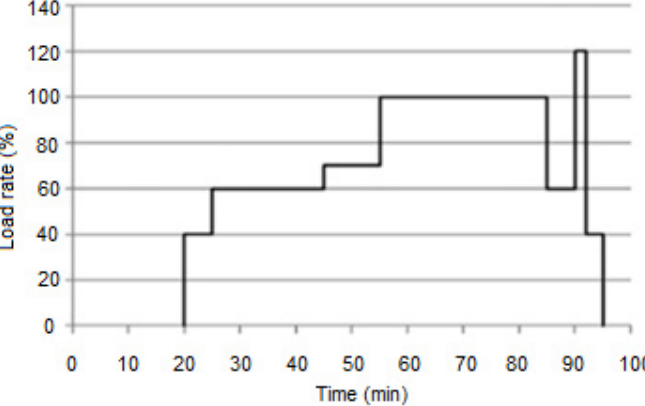
Figure 12. Dalian Institute of Chemical Physics test protocol [4] (Reproduced with permission from Huicui et al. [4], Applied Energy; published by Elsevier Ltd., 2018).